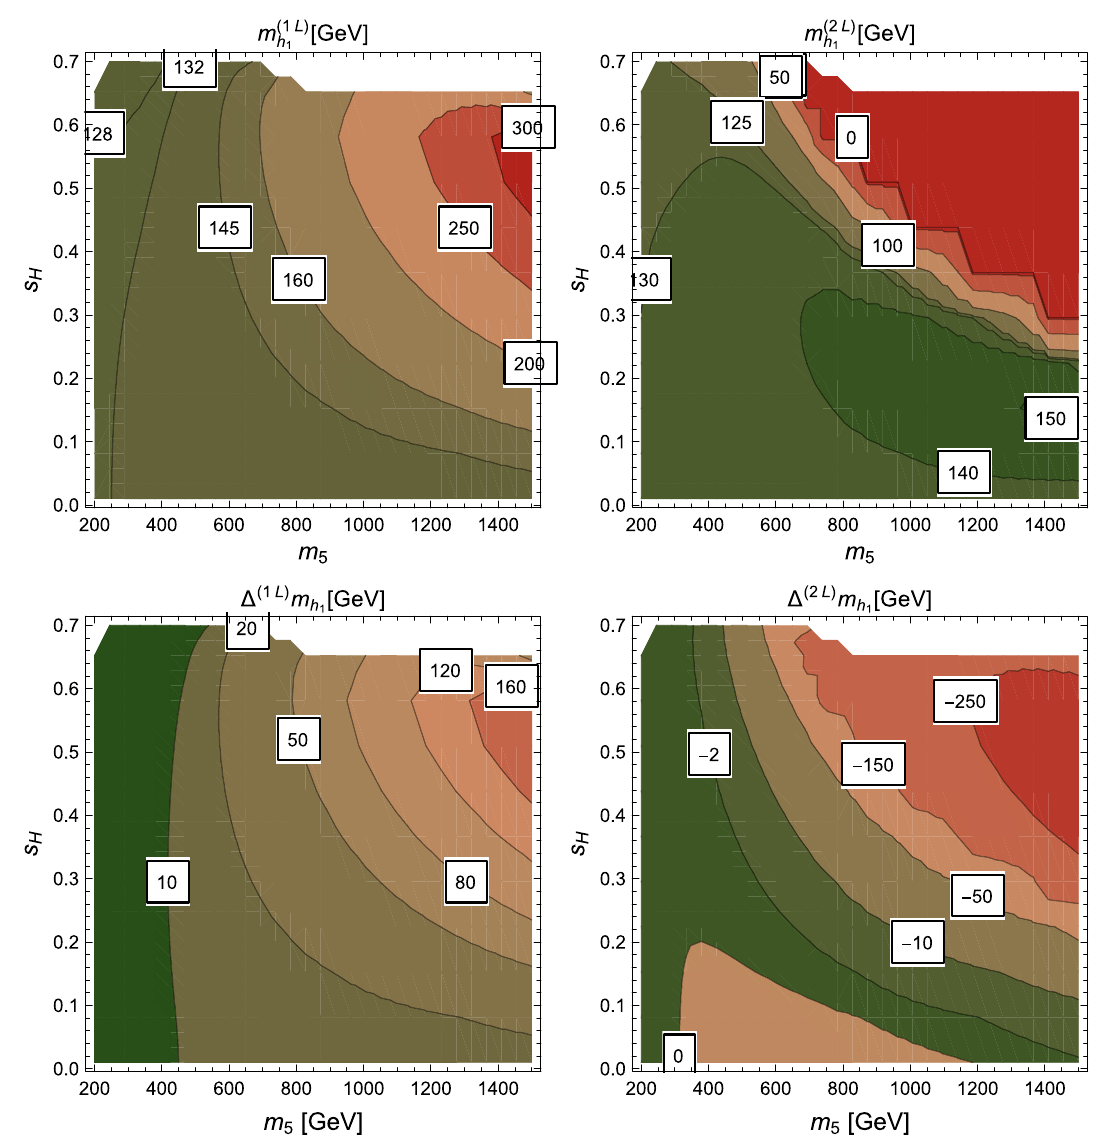
Fig. 11 First row: absolute size of the SM-like Higgs mass in the Georgi–Machacek model as a function of s H and m 5 at including one- (left) and two-loop (right) corrections. Second row: the size of the one- (left) and two-loop (right)